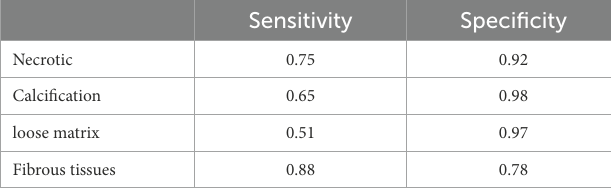
TABLE 4 Pixel-wise segmentation accuracy.